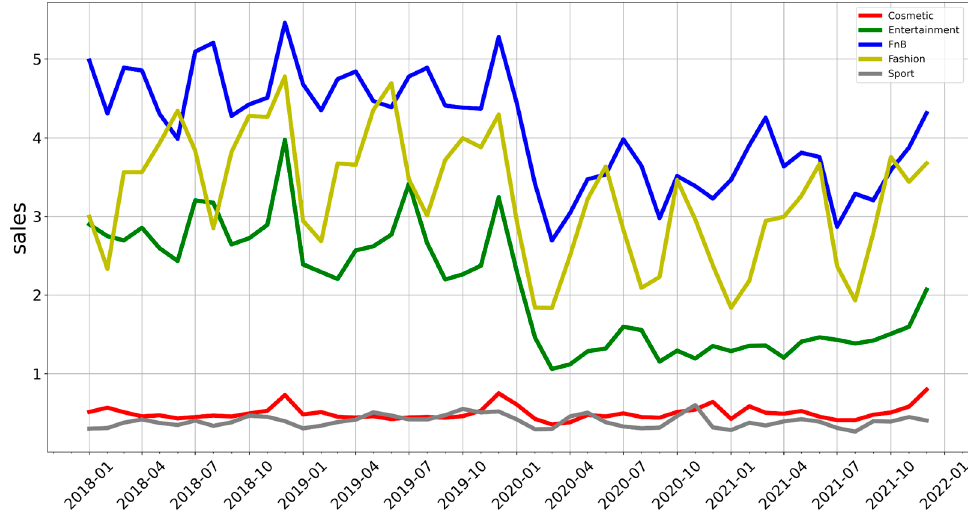
Figure 2. Retail sales of shopping mall from 2018 to 2021.